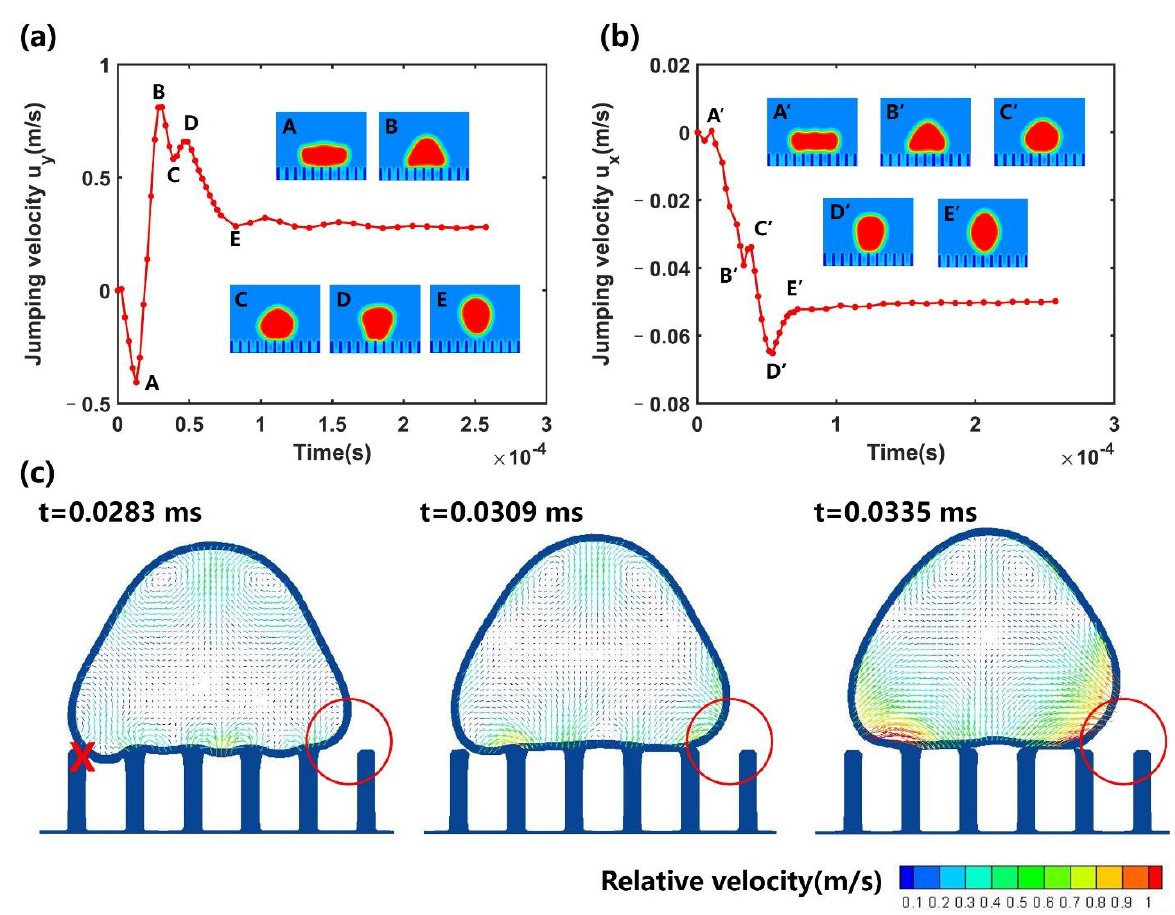
Figure 6. Time evolution of velocity and morphology during the coalescence process in Case R3 ( a ) Time evolution of the vertical droplet velocity. ( b ) Time evolution of horizontal velocity. ( c ) Droplet morphology and vector diagram at different moments.